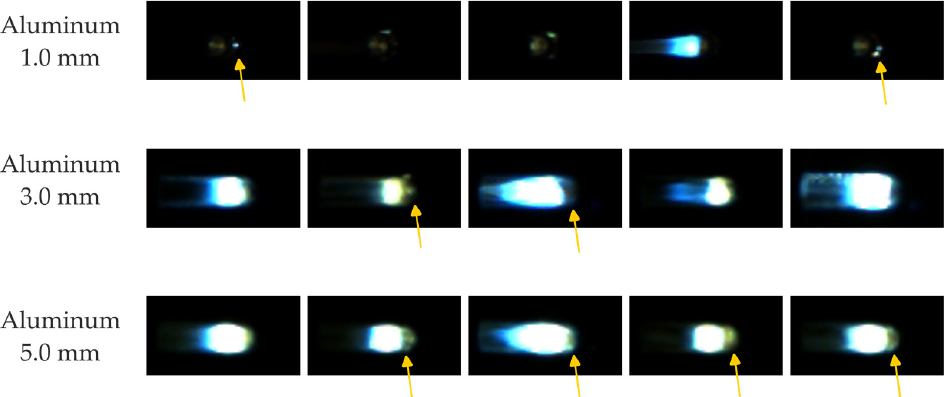
Figure 6. Example images of the kerf in 1.0 mm, 3.0 mm, and 5.0 mm aluminum, recorded with a high-speed camera. Highlighted are the actual positions of the melt pool front in the feed direction by yellow arrows.